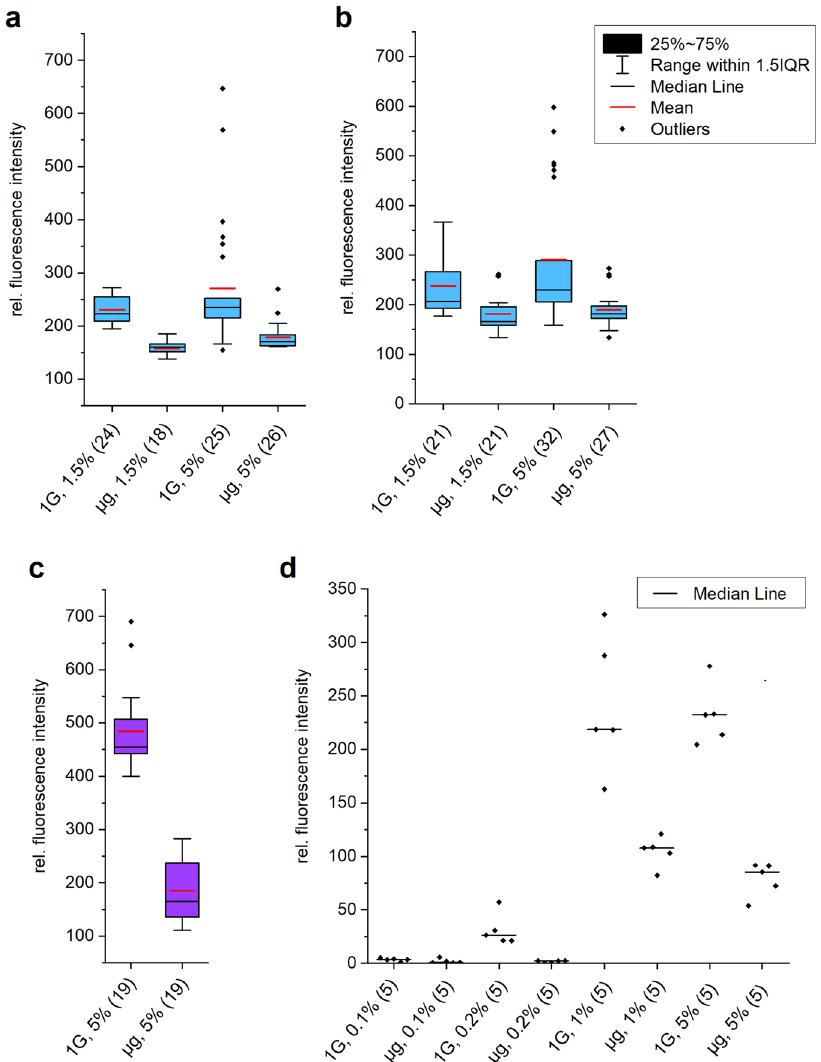
Fig. 6 Spectroscopic quanti fi cation of fl uorescent oligomers incorporated into crystals. Crystal aggregate incorporation in microgravity versus unit gravity control experiments is displayed. The box plots ( a , b , and c ; with symbols explained for each boxplot in b ) show the aggregate incorporation based on fl uorescence intensity analysis, for a lysozyme (SPX10 mission), b lysozyme (SPX 15 mission) and c BSA (SPX15 mission). For d Pf GST (SPX10 mission) all individual data points are included for clarity due to the lower number of crystals under investigation for each experimental condition. Individual data points are fl uorescence intensities of crystals either grown at unit gravity (1 G) or microgravity (µg). The number of crystals analyzed under the respective conditions is provided in brackets and the relative amount of aggregates in % is provided as